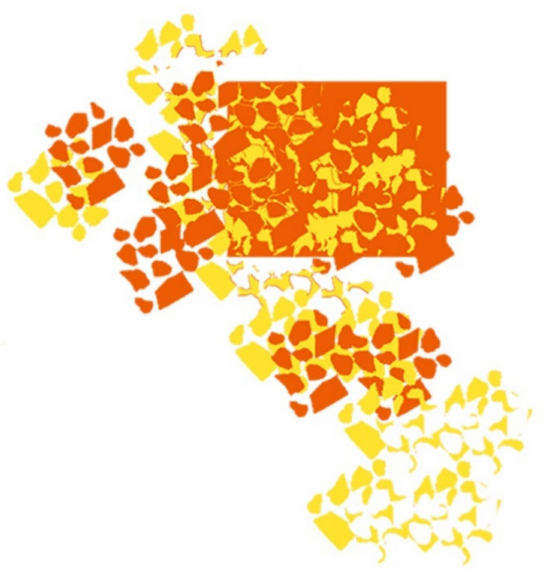
Figure 7. Final study of the M03 module. Sequentially, the M03 module was reflected, giving rise to the M04 module (with measures of 50 cm × 50 cm). The M05 module (with measurements of 60 cm × 35 cm) was created with the intention of facilitating the subsequent process of sewing and patternmak- ing of the mask, keeping the original fitting of the M03 module on the front and creating another design for fitting with the M04 module, on the